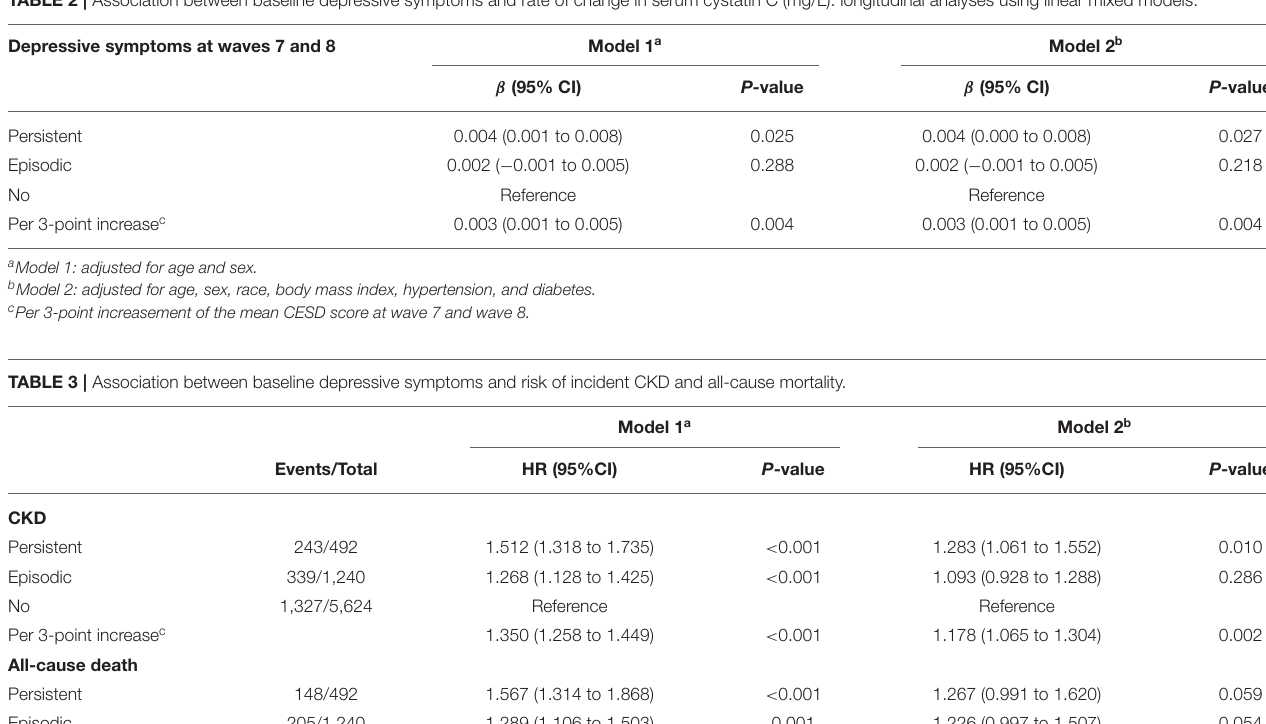
TABLE 2 | Association between baseline depressive symptoms and rate of change in serum cystatin C (mg/L): longitudinal analyses using linear mixed models.